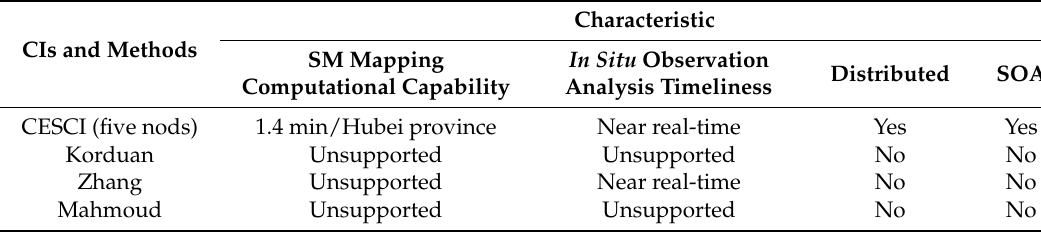
Table 2. Comparisons with other CIs and methods in